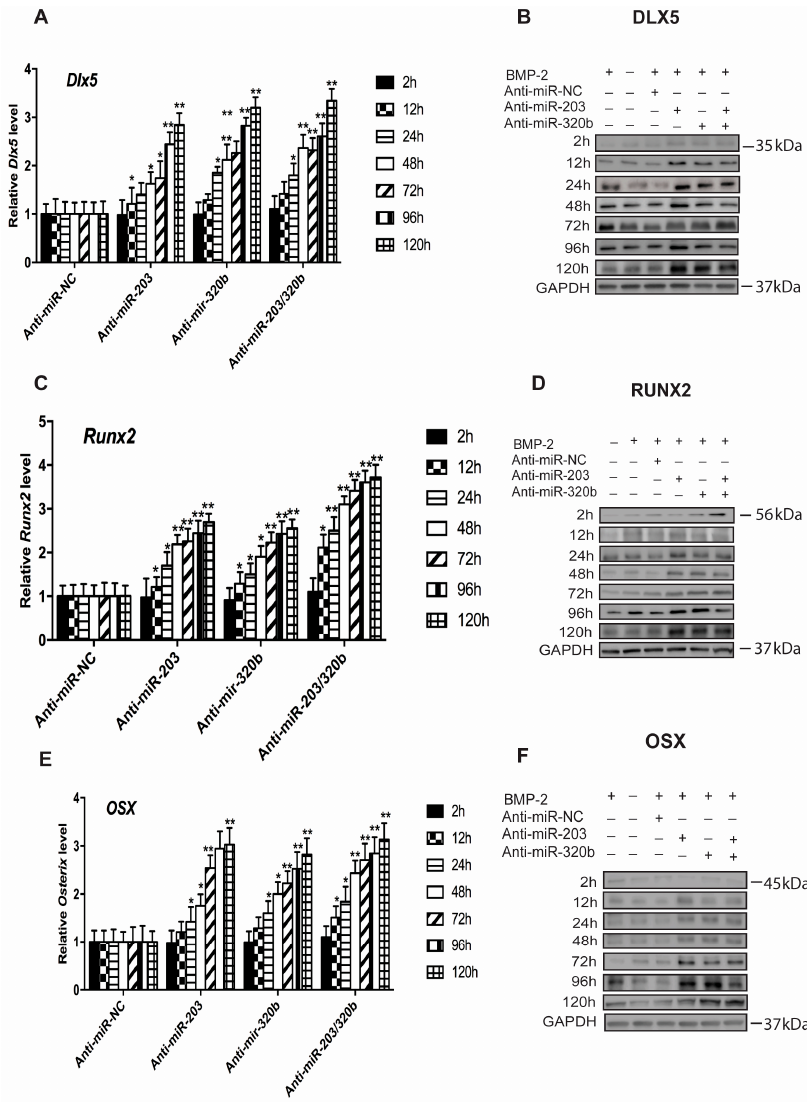
(Figure 4C,D) and Osx (Figure 4E,F) at the mRNA and protein levels up to 120 h when compared to cells treated with anti-miR NC. GAPDH was used as an internal control for the Western blots. GAPDH for only one time point (120 h) is shown as the representative blot for all the time points. GAPDH levels for the rest of the time points are similar. All these results suggest that miR-203 and miR-320b negatively regulates Dlx5 expression at translational level in BMP-2 stimulated osteoblast differentiation, and in turn regulates Runx2 and Osx expression.